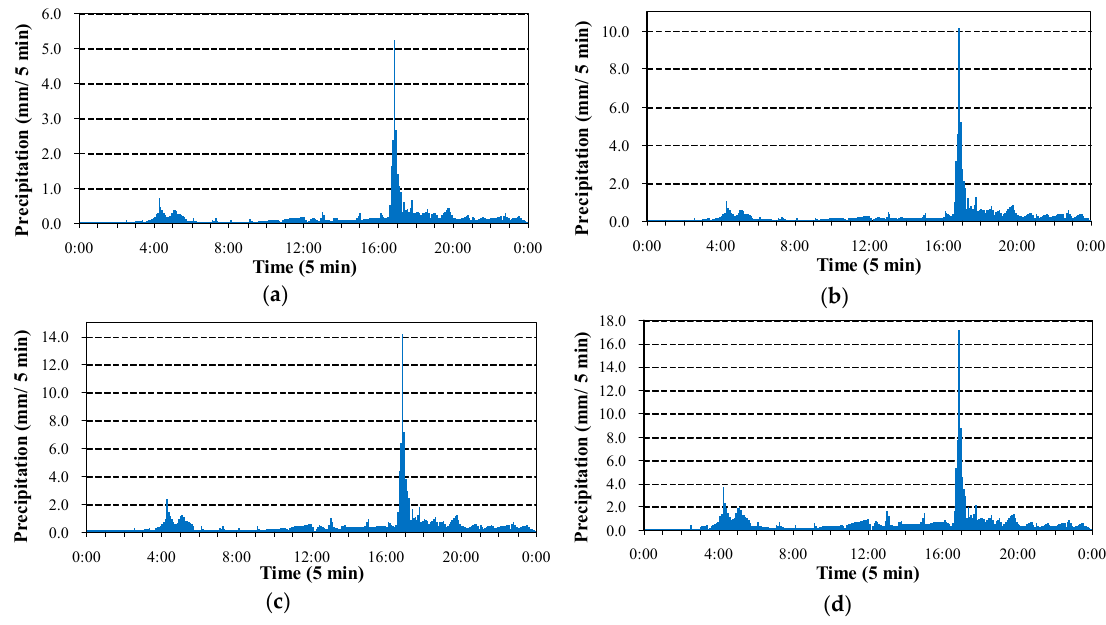
Figure 2. Typical design precipitation processes of different return periods of: ( a ) one year; ( b ) two years; ( c ) five years; and ( d ) ten years.